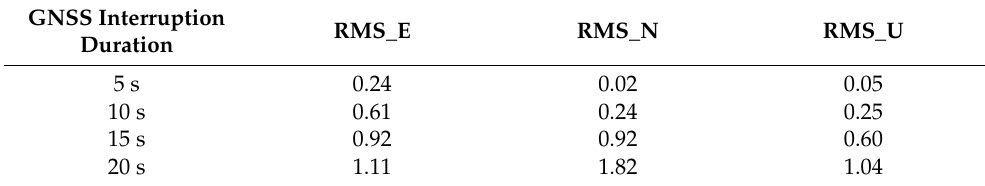
Figure 15. Coupled displacement results of the simulated landslide stability period in Scene 3. Table 9. RMS statistical results when simulating the landslide stability period in Scene 3 (unit: cm).